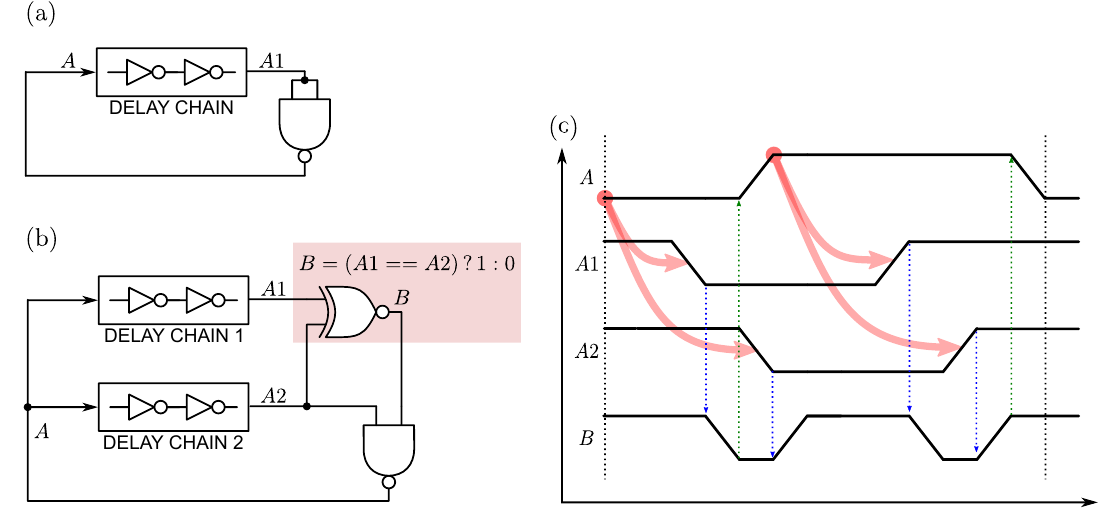
Figure 3. Derivation of a RO with synchronized delay chains: ( a ) starting point representation of a generic RO; ( b ) synchronization principle by a Xnor gate; ( c ) synchronized delay-chain oscilla- tor chronogram.